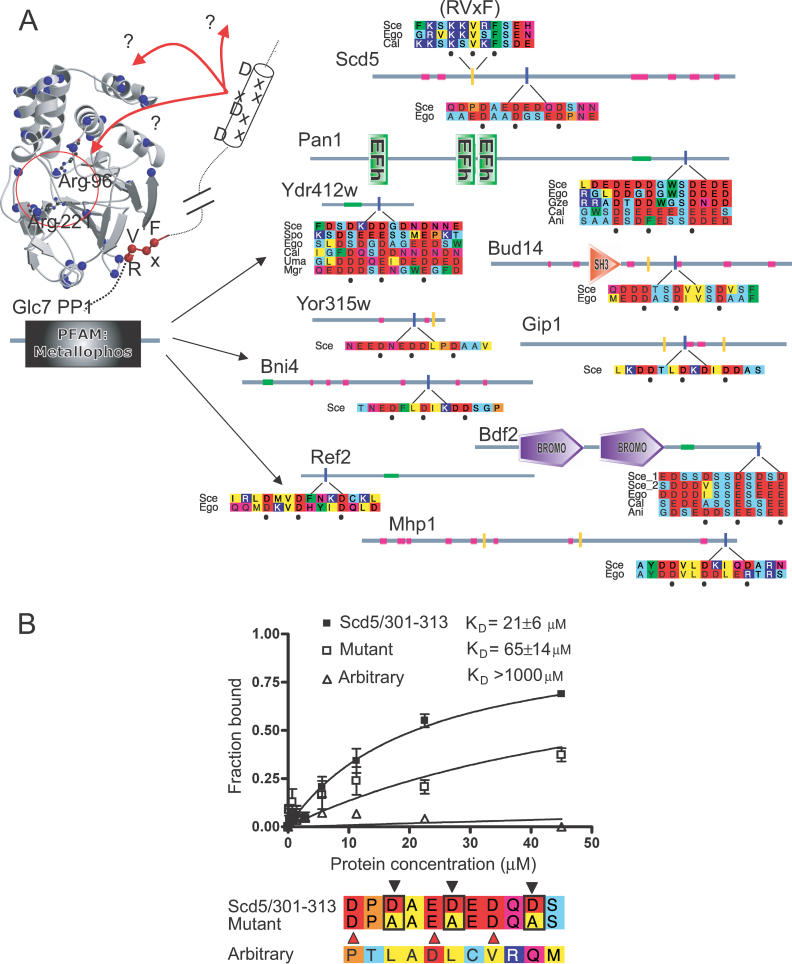
An Acidic Yeast PP1 Binding Motif(A) PP1 (Glc7) with the set of interaction partners containing the DxxDxxxD motifs. Details are as for Figure 3A. Here the location of RVxF motifs (defined as matches to (RK)x0–1(VI)x(FW)) are shown as yellow bars, and low-complexity regions are magenta. The figure also shows the structure of PP1 bound to RVxF (red spheres) [54] with a hypothetical helix containing the motif. Blue spheres show the location of Arg or Lys residues, and the active site is circled with critical Arginines shown in ball-and-stick. Red arrows show hypothetical interactions of the motif either with sites on PP1 or elsewhere. Ani, Aspergillus nidulans; Cal, Candida albicans; Ego, Eremothecium gossypii; Gze, Gibberella zeae; Mgr, Magnaporthe grisea; Sce, S. cerevisiae; Spo, Schizosaccharomyces pombe; Str, Salinospora tropicalis; Uma, Ustilago maydis; Xla, Xenopus laevis.(B) Saturation curves, showing bound fraction as a function of PP1 concentration. The polarization values (mP) were normalized to an extrapolated Bmax because Bmax could not be reached experimentally. Other details are as given in Figure 3B. Red triangles in the lower panel show the location of the near match to the motif in the mutated sequence.